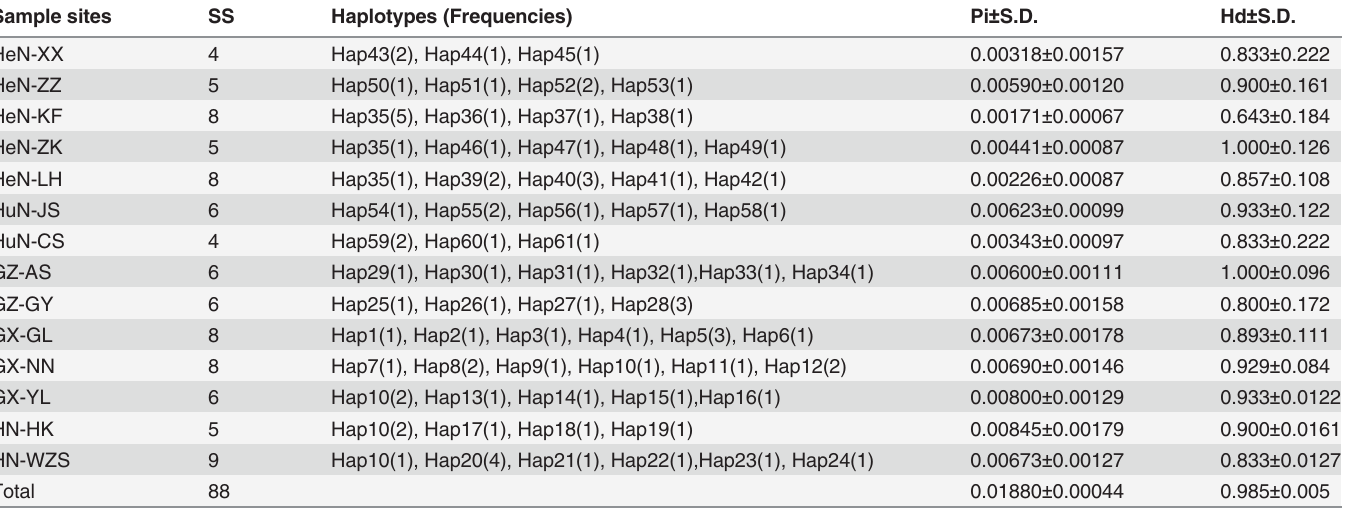
Table 1. Sampling haplotypes with frequencies and genetic diversities of Spirometra erinaceieuropaei . Sample